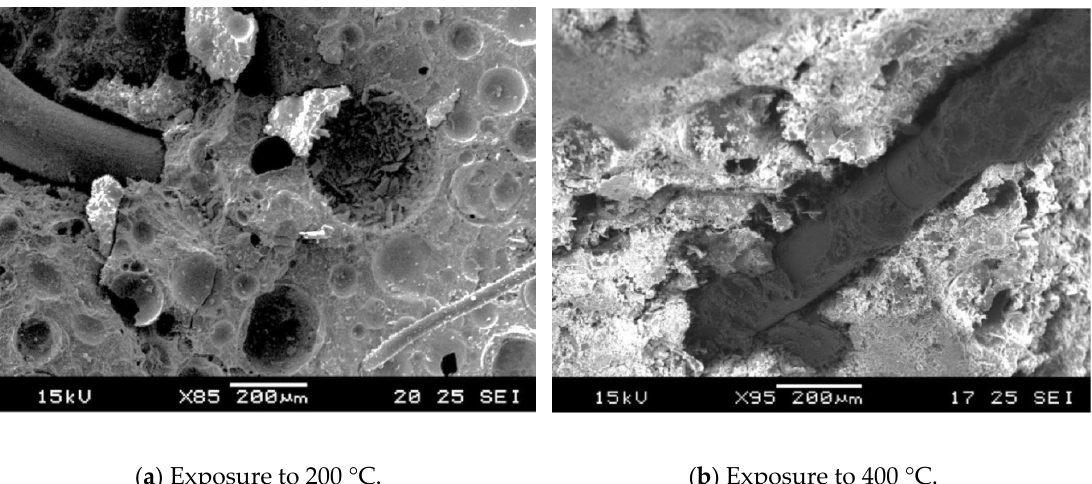
Figure 12. Morphologies of fibers in SFRC exposed to different high temperatures of 200°C (a) and 400°C (b) [100].